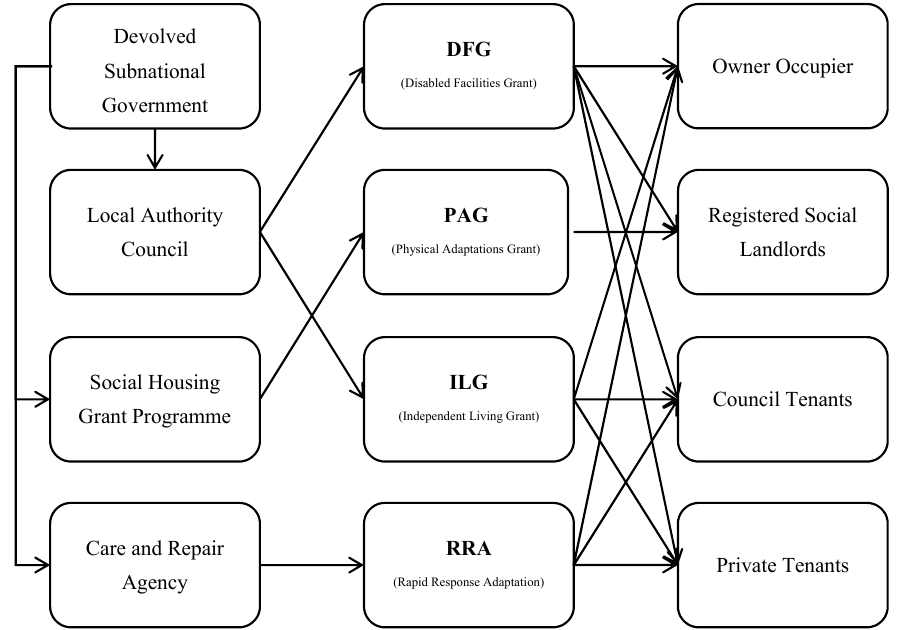
Figure 1. Comparison of prevailing independent living schemes in the United Kingdom. Note: the left blocks are the funders of the schemes in the middle blocks, and the right blocks are the targeted applicants.